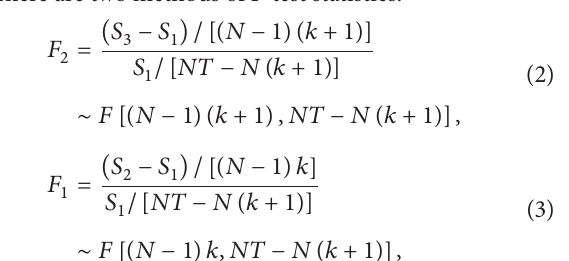
𝐻 1 : The coefficient of variables and intercepts were all the same for the panel cities. The model was the mixed regression